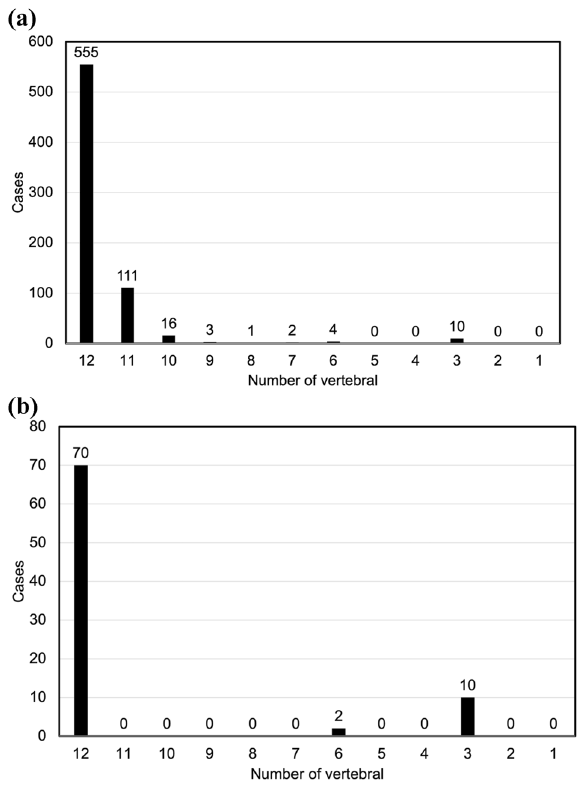
Figure 5. ( a ) Number of thoracic vertebrae existing in the CT data (702 cases; antemortem database). ( b ) Number of thoracic vertebrae existing in the CT data (82 cases of postmortem data).